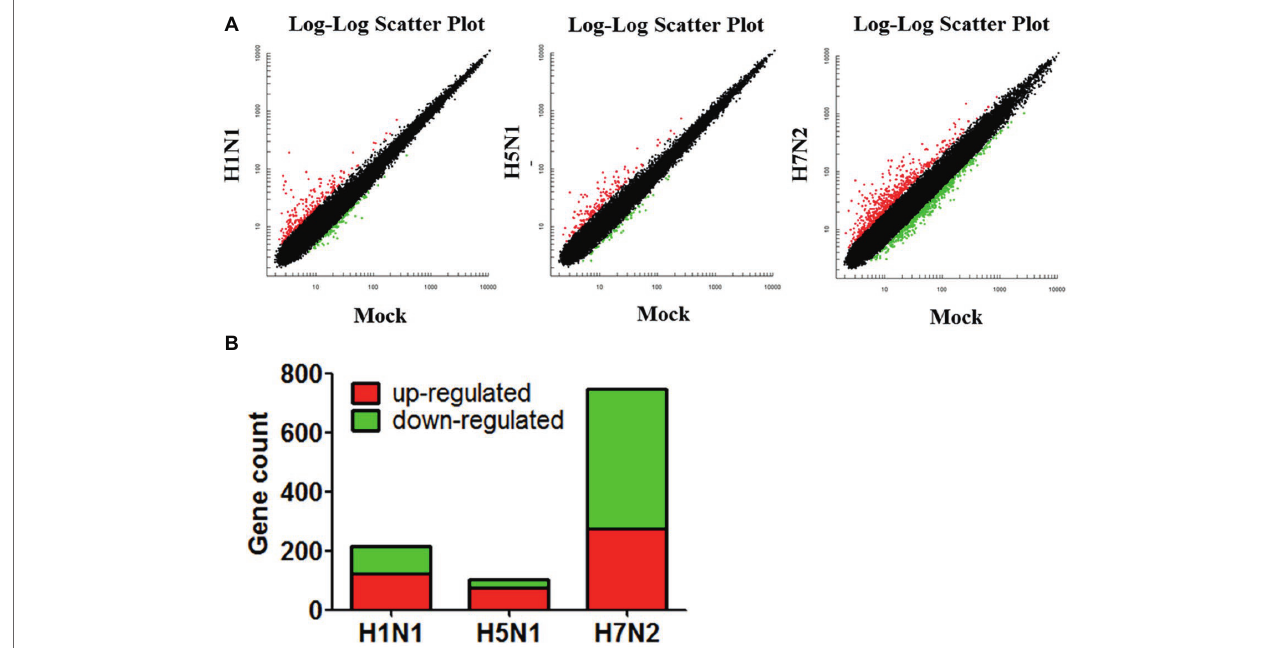
FIGURE 1 | Identification and quantification of differentially abundant genes between IAV-infected P815 cells and uninfected cells. (A) Scatter plots of gene abundance ratio in H1N1vsMock, H5N1vsMock, and H7N2vsMock, respectively. (B) Bar chart showing the up-regulated DEPs (red) and down-regulated DEGs (green) in P815 cells infected with different subtypes of IAV (H1N1vsMock, H5N1vsMock, and H7N2vsMock), respectively.